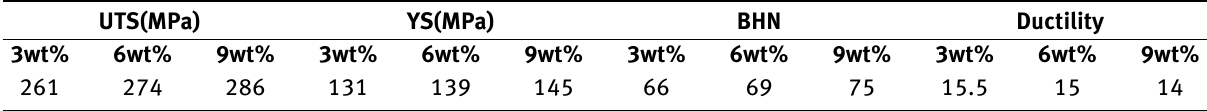
Table 3: Mechanical properties of AA7075 (composite) with weight percentage of Al 2 O 3